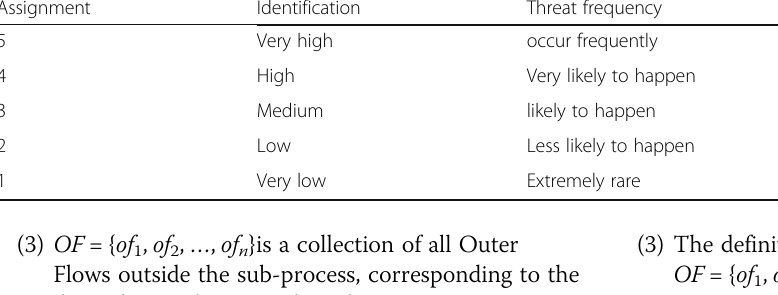
Table 3 Attack probability assignment table Assignment